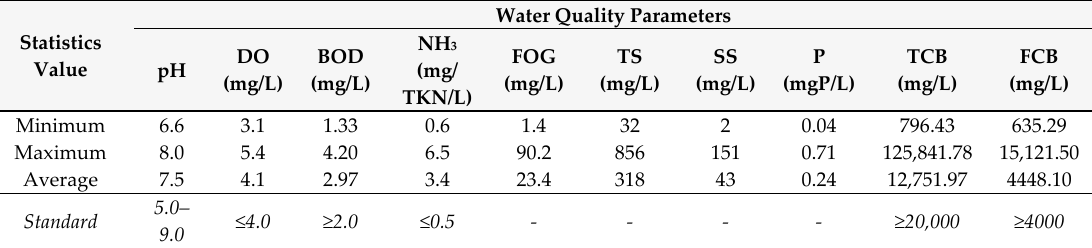
Table 1. Summary of the quality of surface water and